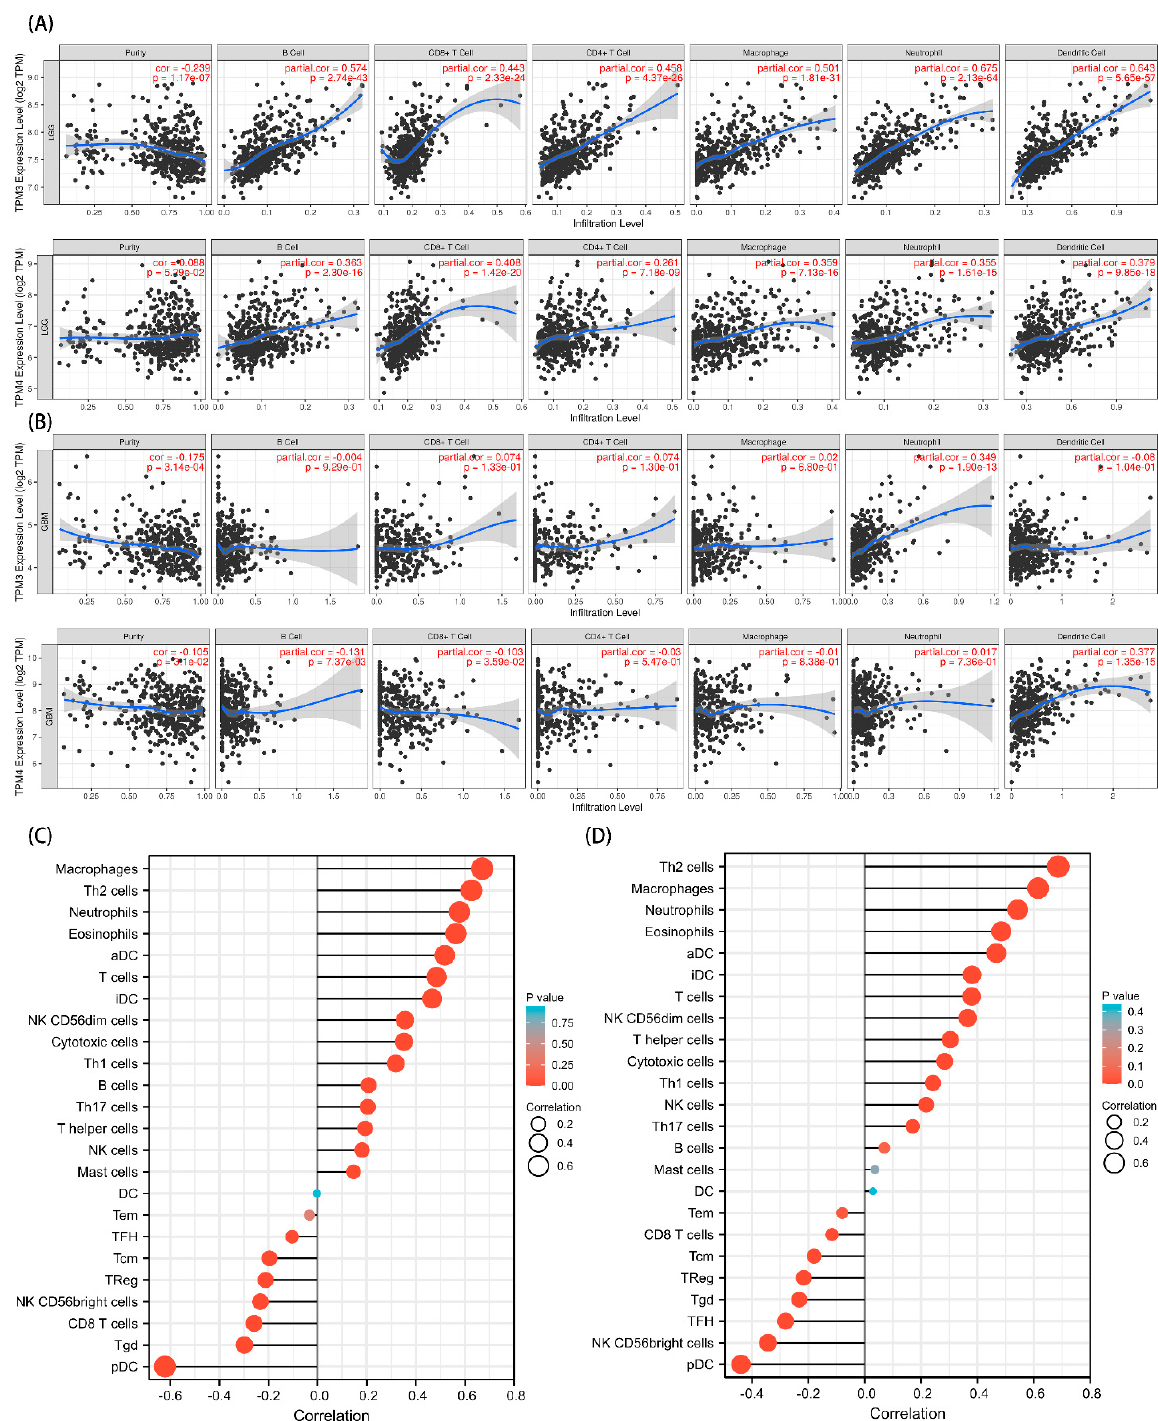
Figure 11. Correlation analysis between TPM3 and TPM4 expressions and immune cell filtration. ( A ) The correlation of TPM3/TPM4 with the six types of immune cell filtration levels in LGG based on the TIMER database. ( B ) The correlation of TPM3/TPM4 with the six types of immune cell filtration levels in GBM based on the TIMER database. ( C ) The correlation of TPM3 with 24 types of immune cells in glioma based on TCGA data. ( D ) The correlation of TPM4 with 24 types of immune cells in glioma based on TCGA